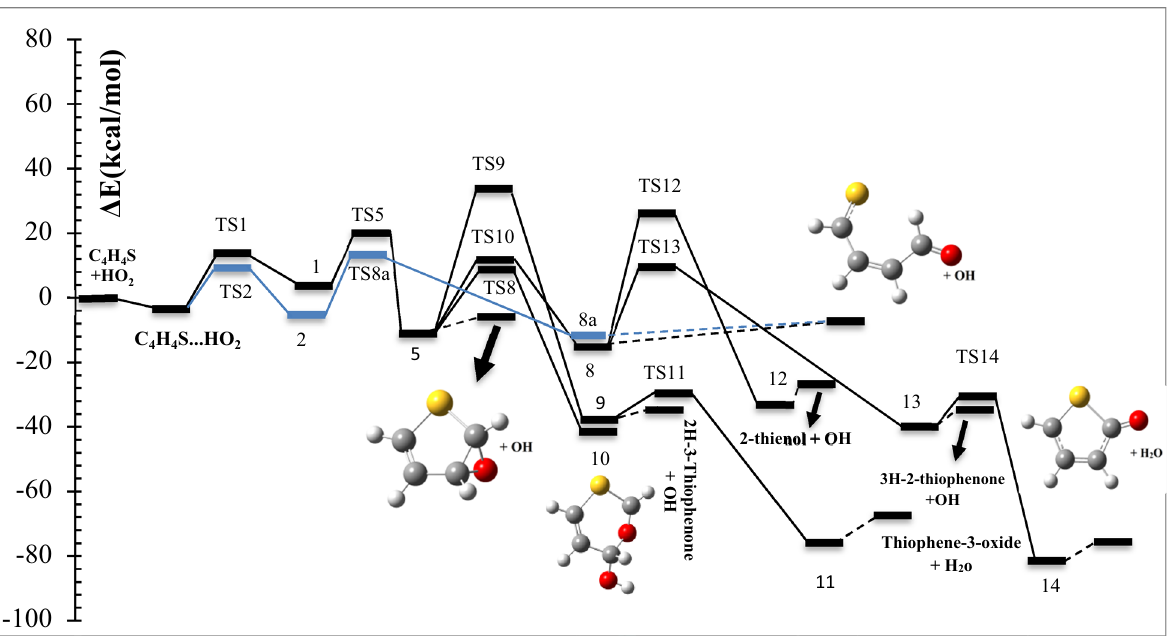
Figure 3. Potential energy profile for the thiophene + HO 2 reaction including the addition of terminal oxygen of hydroperoxyl radical to α-C (blue) and β-C (black) carbons and reactions of obtained products sketched at the BD(T) 6-31 + g(d,p) level.